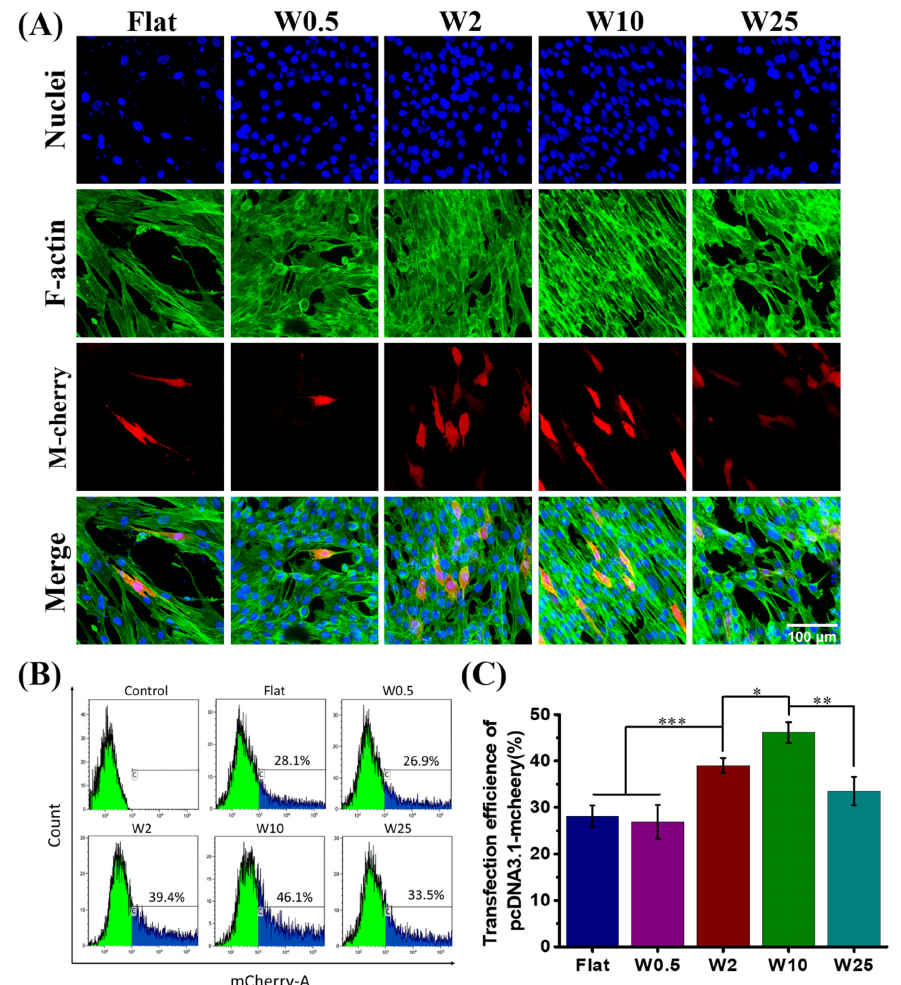
Figure 4. Influence of nano- and micropatterns on the transfection capacity of myoblast cells. ( A ) Representative fluorescent images of transfected myoblast cells on wave-like PDMS. F-actin and cell nuclei were stained with FITC-labeled phalloidin (green) and by DAPI (blue), respectively. Successfully transfected cells are expressed as m-Cherry (red). ( B ) Flow cytometry profiles obtained after the treatment with LF2000/p-DNA encoding m-Cherry proteins. ( C ) Quantification data of transfected cells grown on different topographies. Three independent experiments were per- formed. Data are shown as mean ± standard deviation (SD), and * p < 0.05, ** p < 0.01, *** p < 0.001. Scale bar is 100 µm and applies to all images.